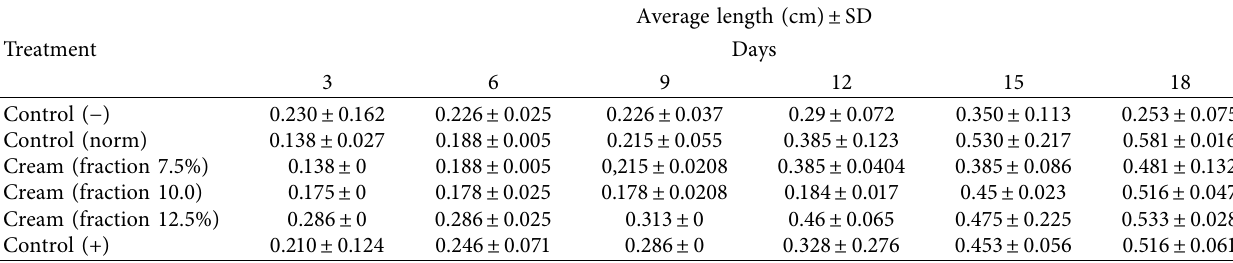
Table 3: Cream activity on rabbit hair growth.